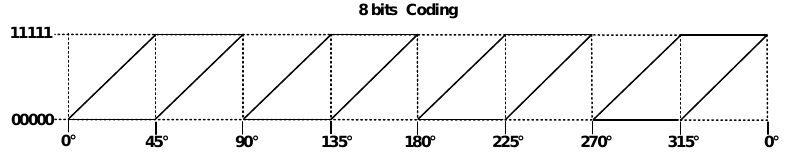
Figure 8. Eight-bit encodings with competition.